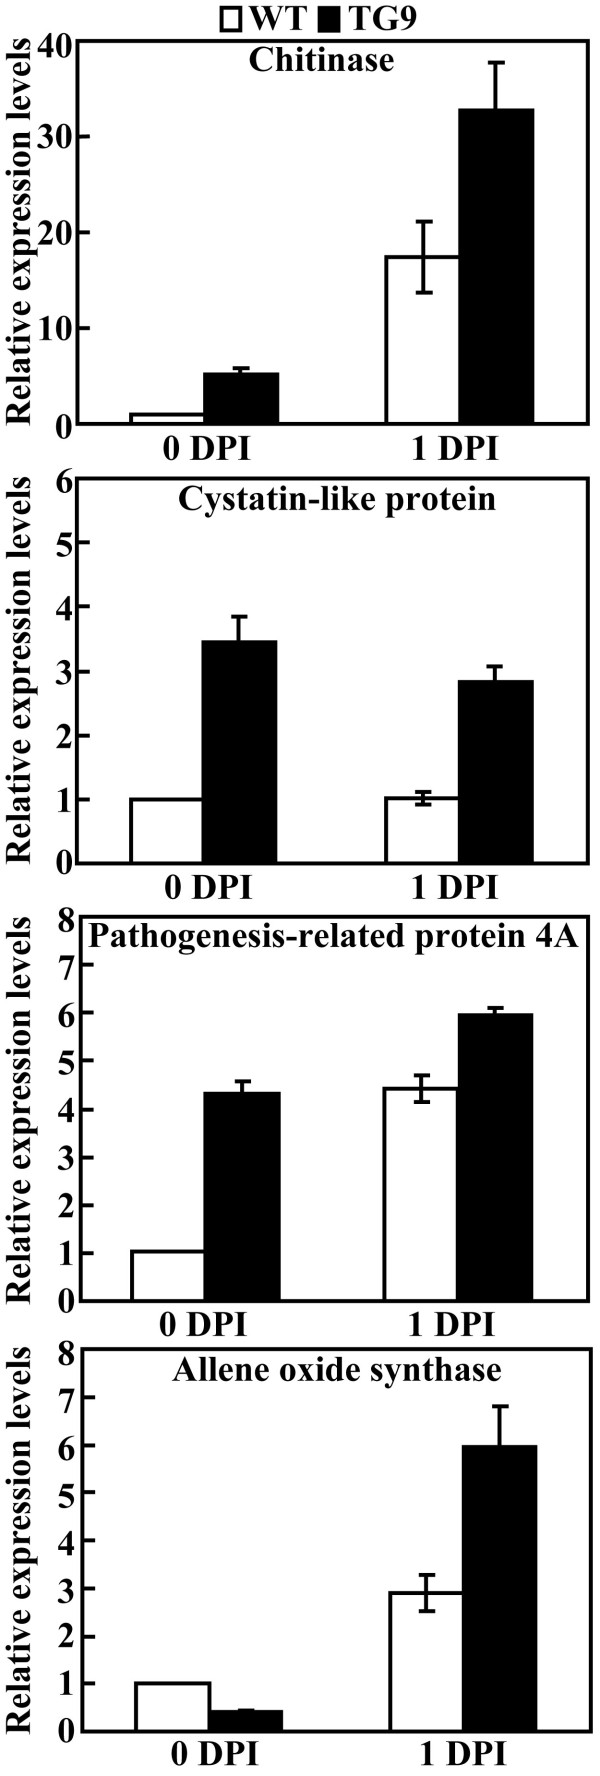
Quantitative real-time RT-PCR analysis on expression levels of defense-related genes in the wild type (WT) and transgenic line (TG9) before and after Xac inoculation. Transcriptional levels of chitinase, cystatin-like protein, pathogenesis-related protein 4A (PR4A) and allene oxide synthase (AOS) were assessed by quantitative real-time RT-PCR in the WT and TG9 before (0 DPI) and 1 d after (1 DPI) Xac inoculation.